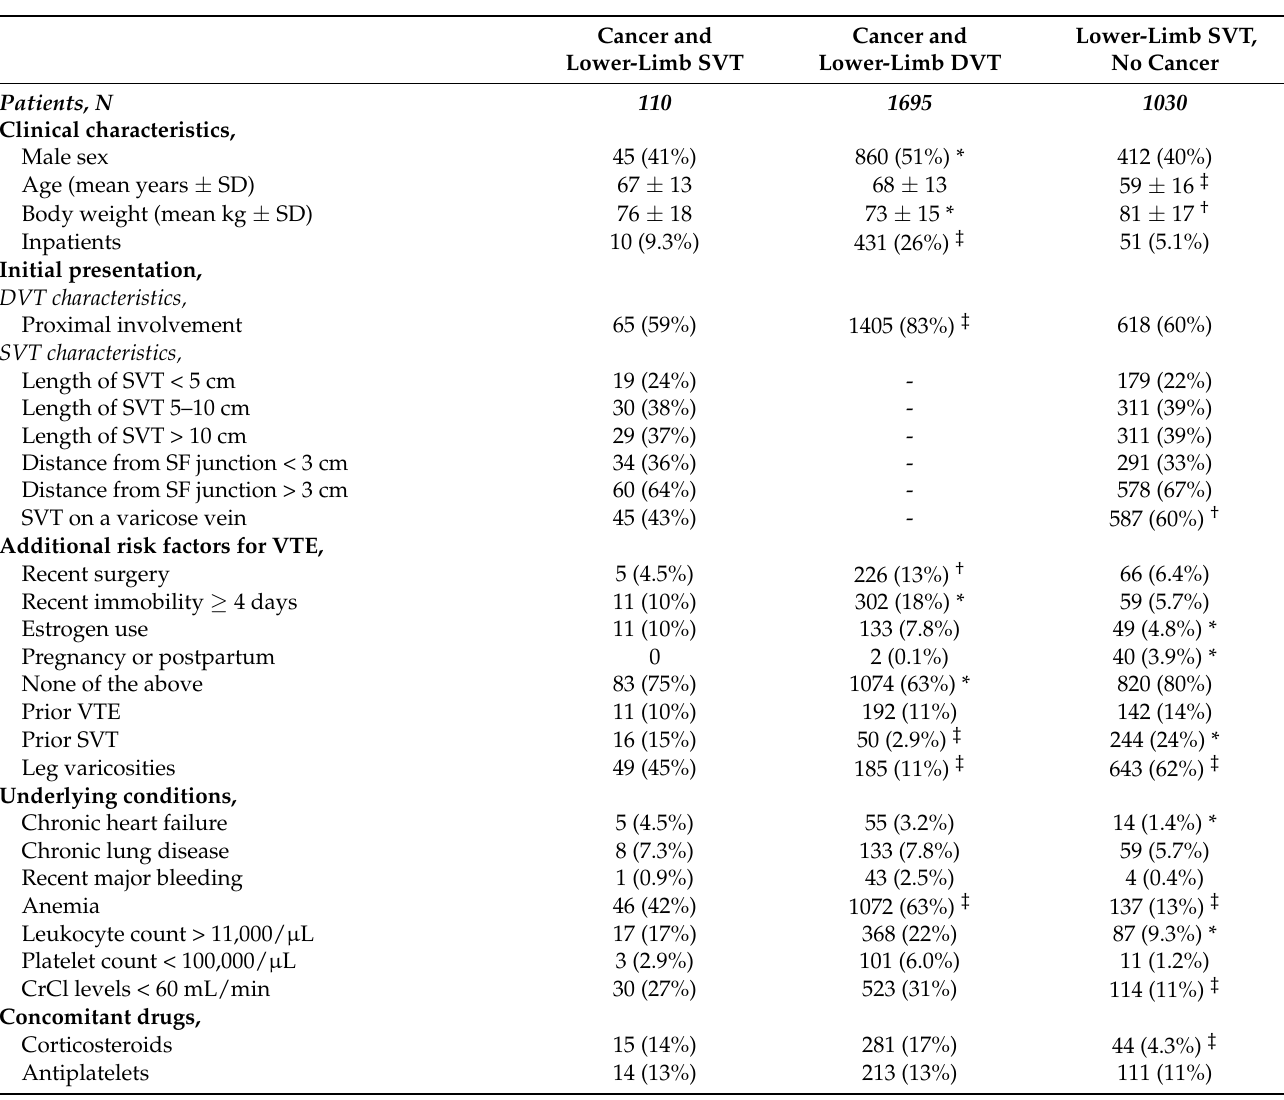
Table 1. Clinical characteristics.